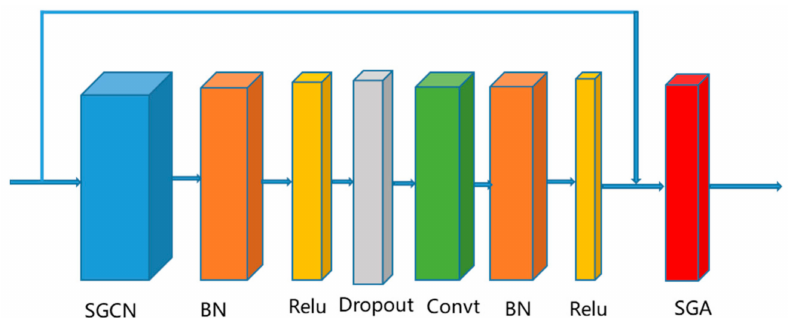
Figure 3. Composition of the AGCN. It consists of SGCN, a standard temporal convolution layer, and a sub-graph